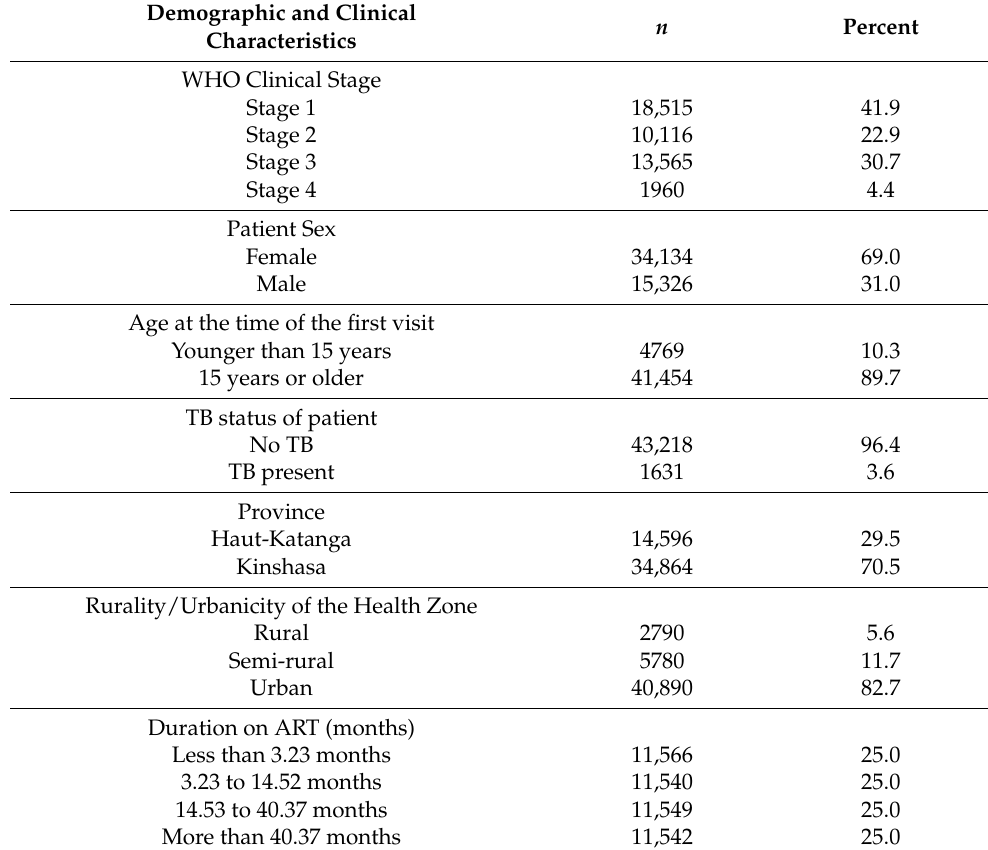
Table 1. Descriptive demographic and clinical characteristics of patients in HIV/AIDS clinics of Haut-Katanga and Kinshasa provinces, Democratic Republic of Congo, 2014–2019. Demographic and